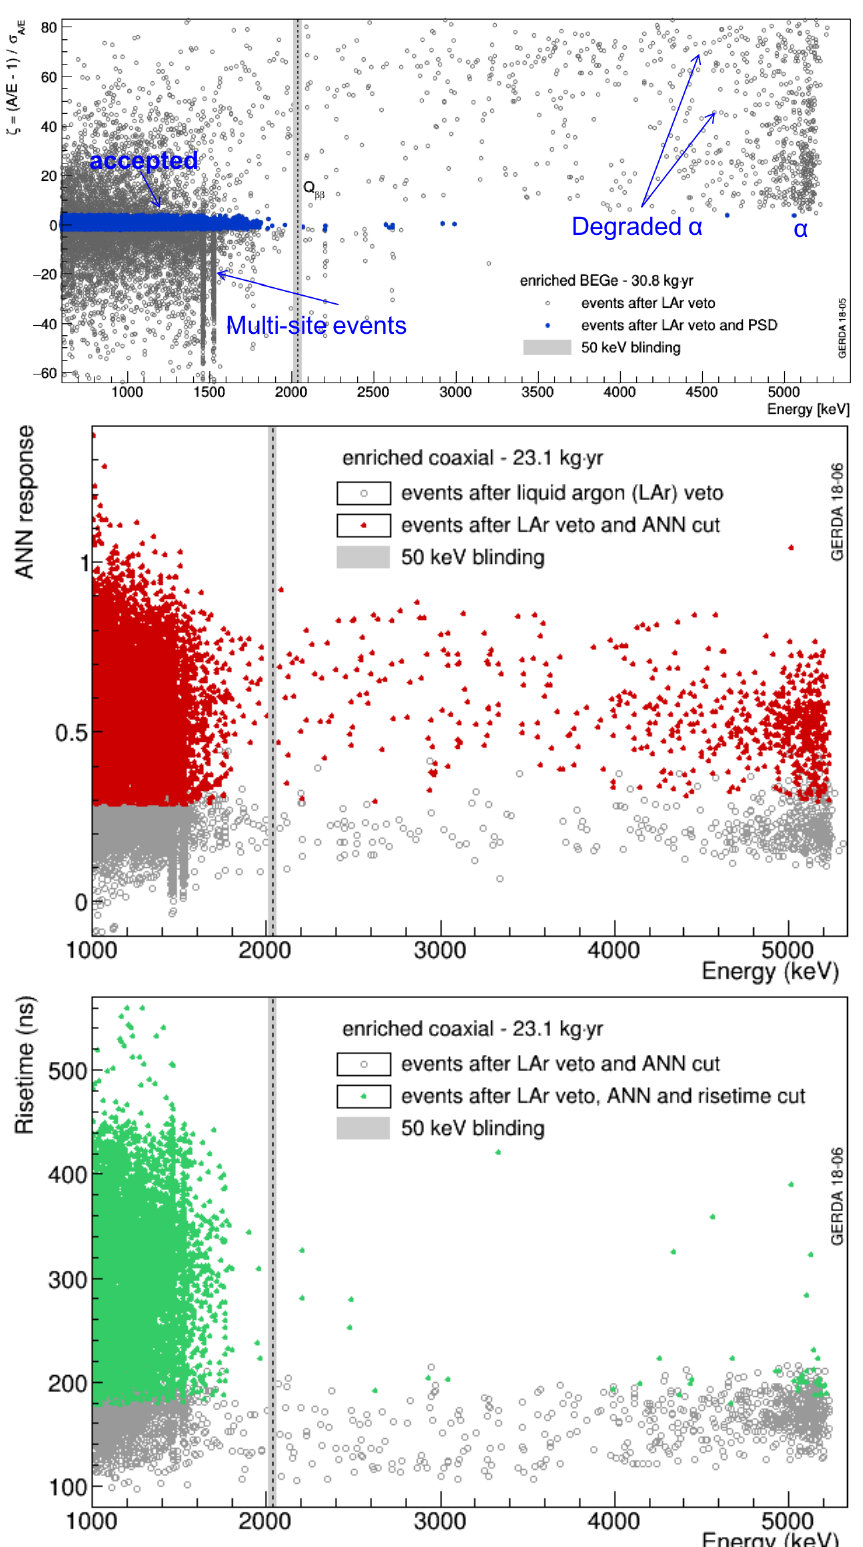
Figure 4. PSD estimators plotted vs. energy for Phase II BEG E ( top ) and C OAX ( middle ) data sets: for C OAX the rise-time parameter vs. the energy is also shown ( bottom ). The empty circles are all the events prior the active cuts, while the filled coloured circles are the events surviving the cut on the PSD